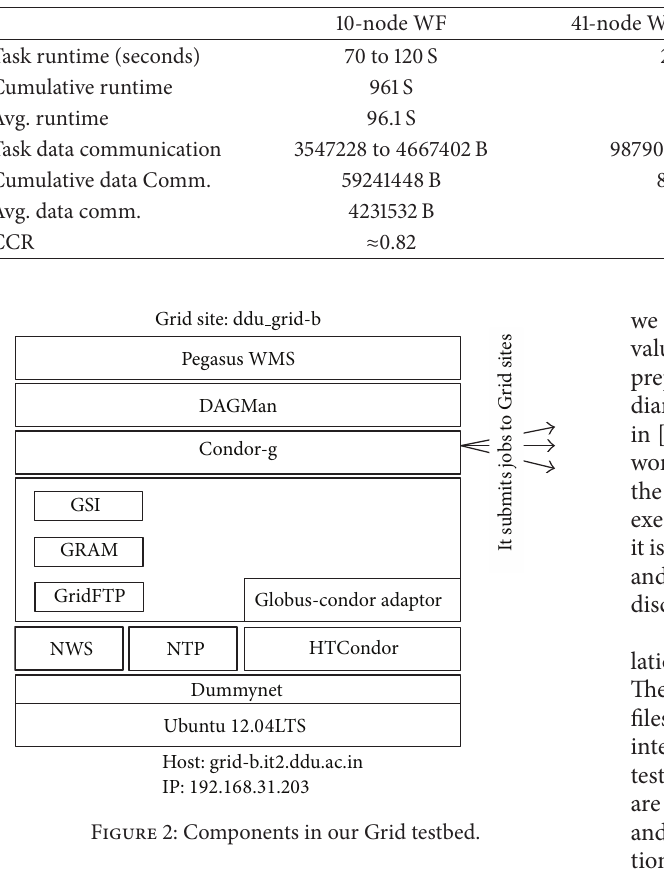
Table 2: Information of three test workflows.